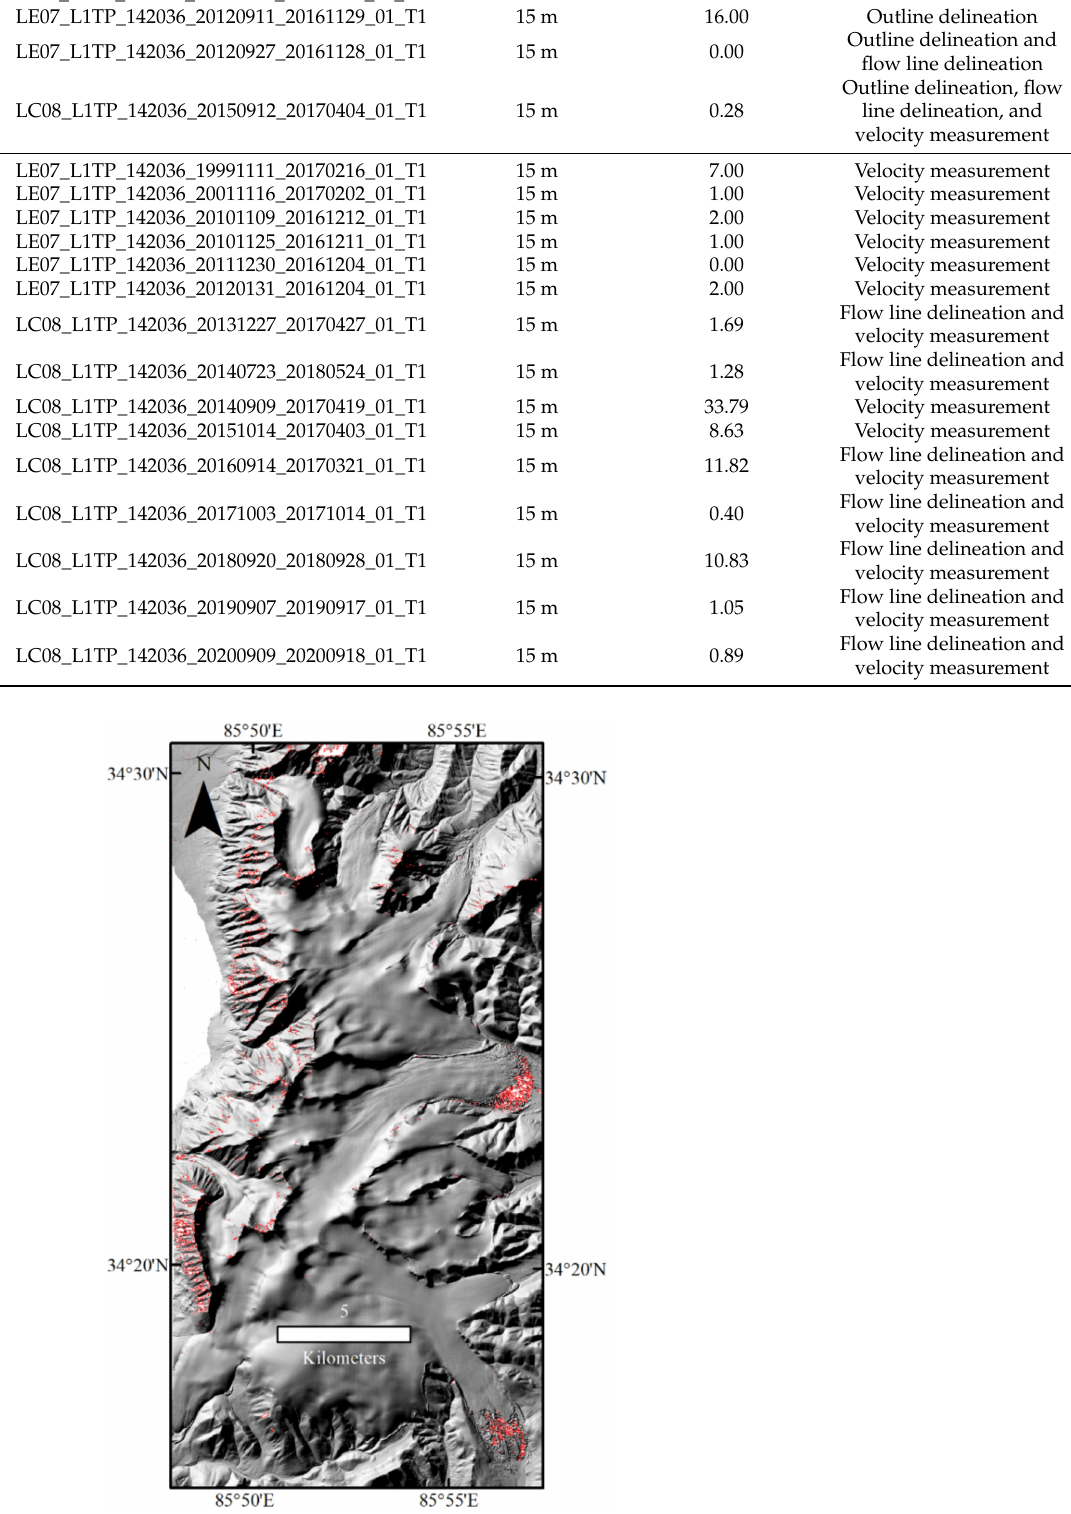
Figure A2. Voids in